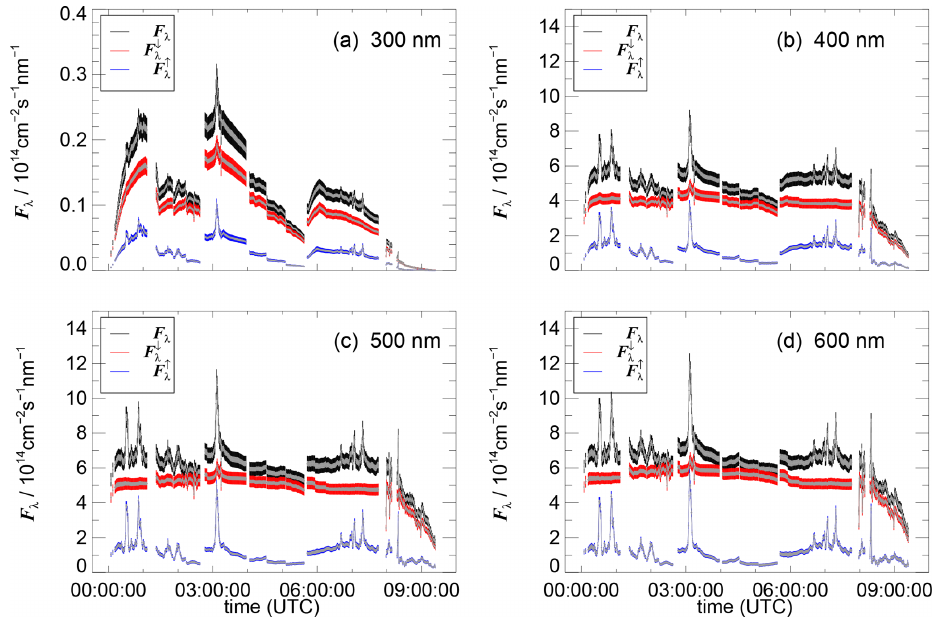
↓ ↑ Figure 18. Total ( F λ ), downward ( F ) and upward ( F ) spectral actinic flux densities of the HALO flight shown in Fig. 17 for the four λ λ selected wavelengths in panels (a) – (d) . The colour-coded error bars correspond to total uncertainties, including those from corrections and calibrations (Sect. S7). The overlying grey error bars indicate the uncertainties from the corrections